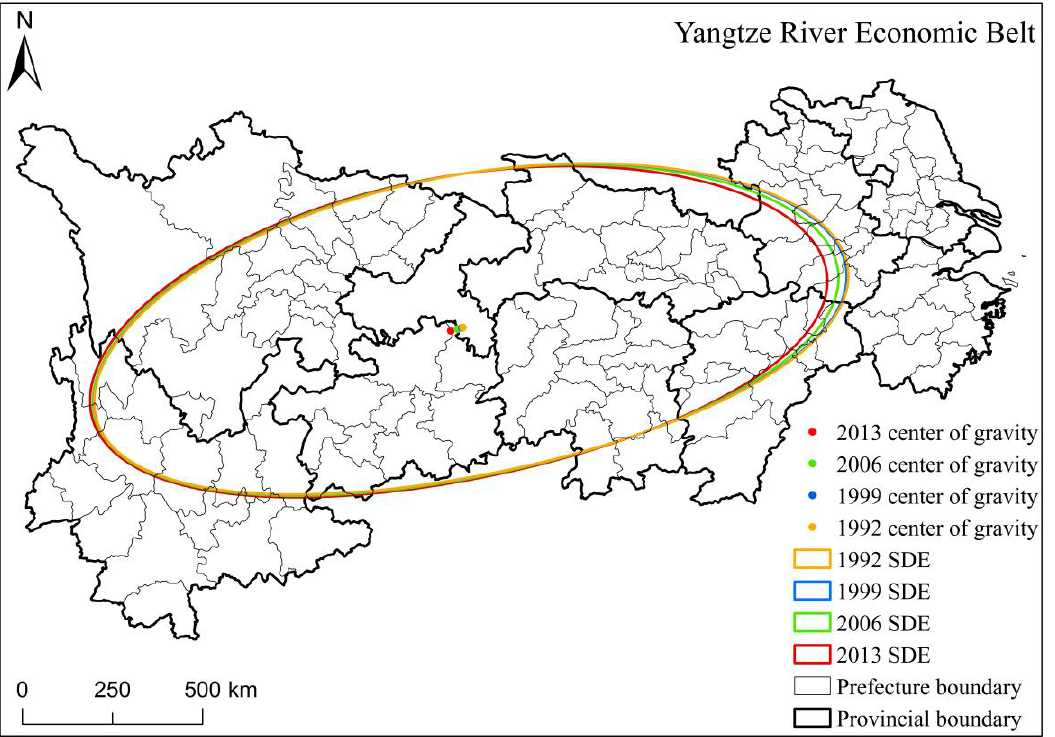
Figure 5. Standard deviation ellipse of urban land expansion in the YREB. Remote Sens. 2020 , 12 , x FOR PEER REVIEW